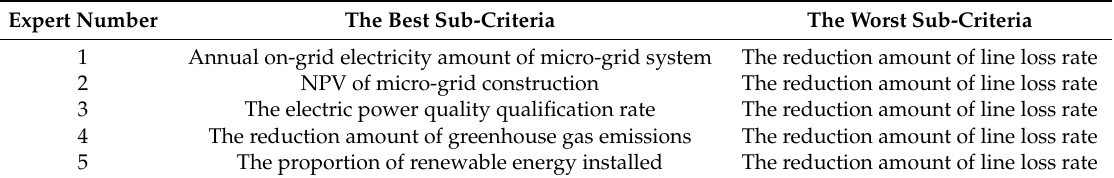
Table 7. The best and the worst sub-criteria selected by five